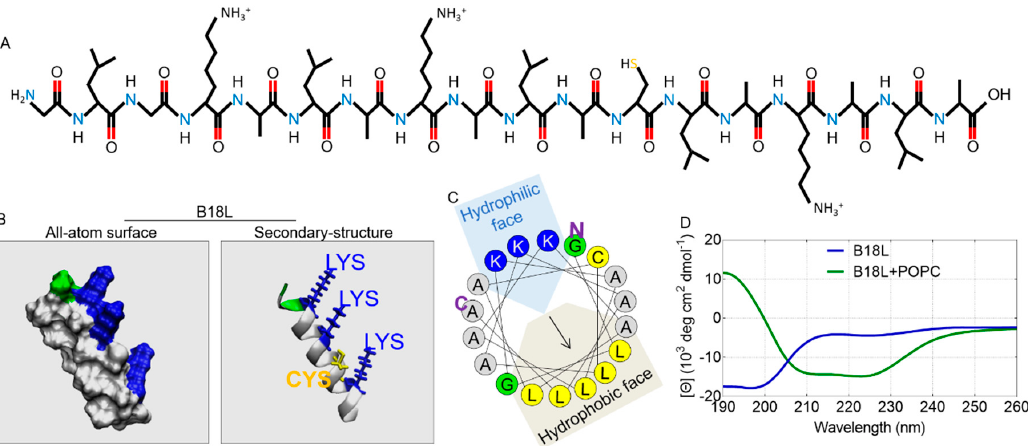
Figure 1. Structural properties of B18L: ( A ) Chemical structure of B18L. ( B ) PEP-FOLD3 prediction for B18L. Left panel shows all-atom surface and right panel shows secondary structure with four residue side chains (LYS and CYS). Color code: blue: basic residue, green: polar residue, white: non-polar residue and yellow: CYS residue. ( C ) Helical wheel projection of B18L re-drawn based on Heliquest, N : N-terminus and C : C-terminus. ( D ) Circular dichroism (CD) spectrum of B18L in water or 1-palmitoyl-2-oleoyl-glycero-3-phosphocholine (POPC) lipid solution.